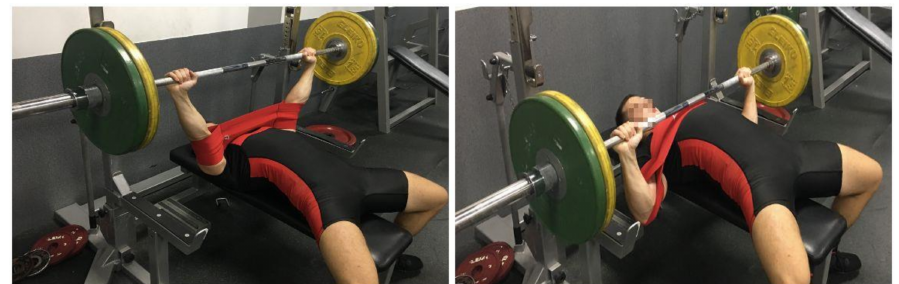
Figure 2. SS placement during a sample flat bench press repetition. Participants were instructed to wear the SS sleeve in the middle of the